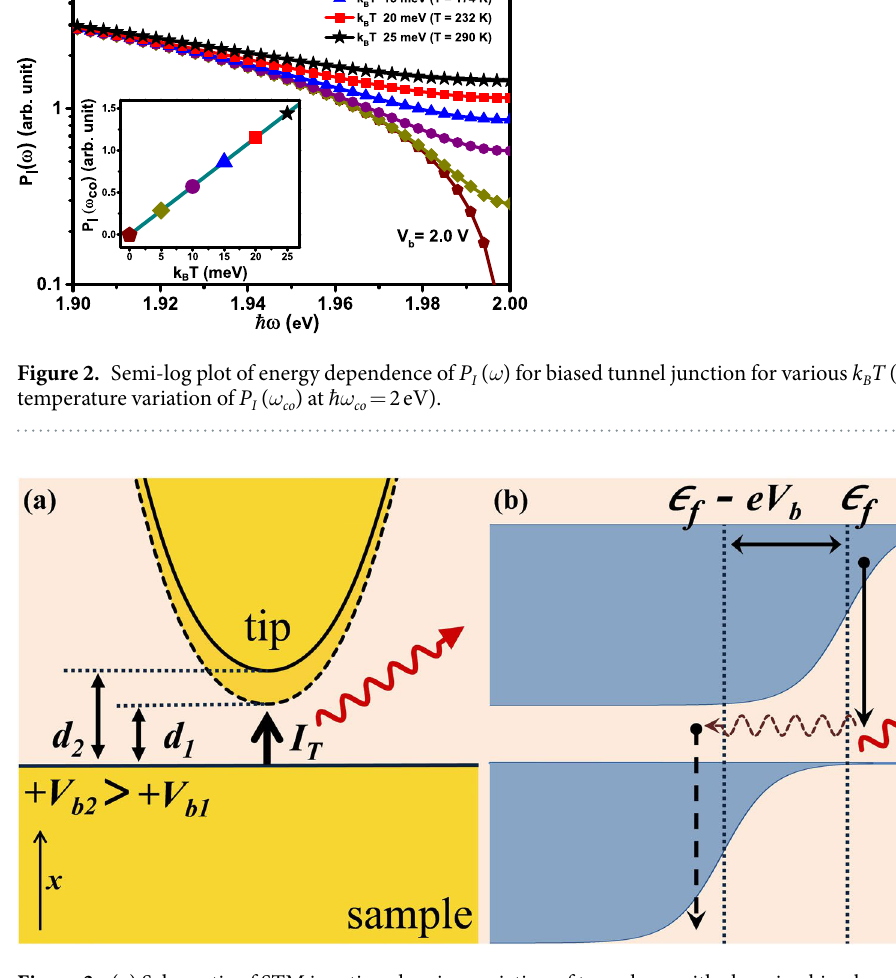
Figure 3. ( a ) Schematic of STM junction showing variation of tunnel gap with changing bias, keeping current constant. ( b ) Tip and sample Fermi functions at finite T , showing inelastic tunnelling of thermally excited electron from tip to sample giving rise to emission ħ ω > eV b